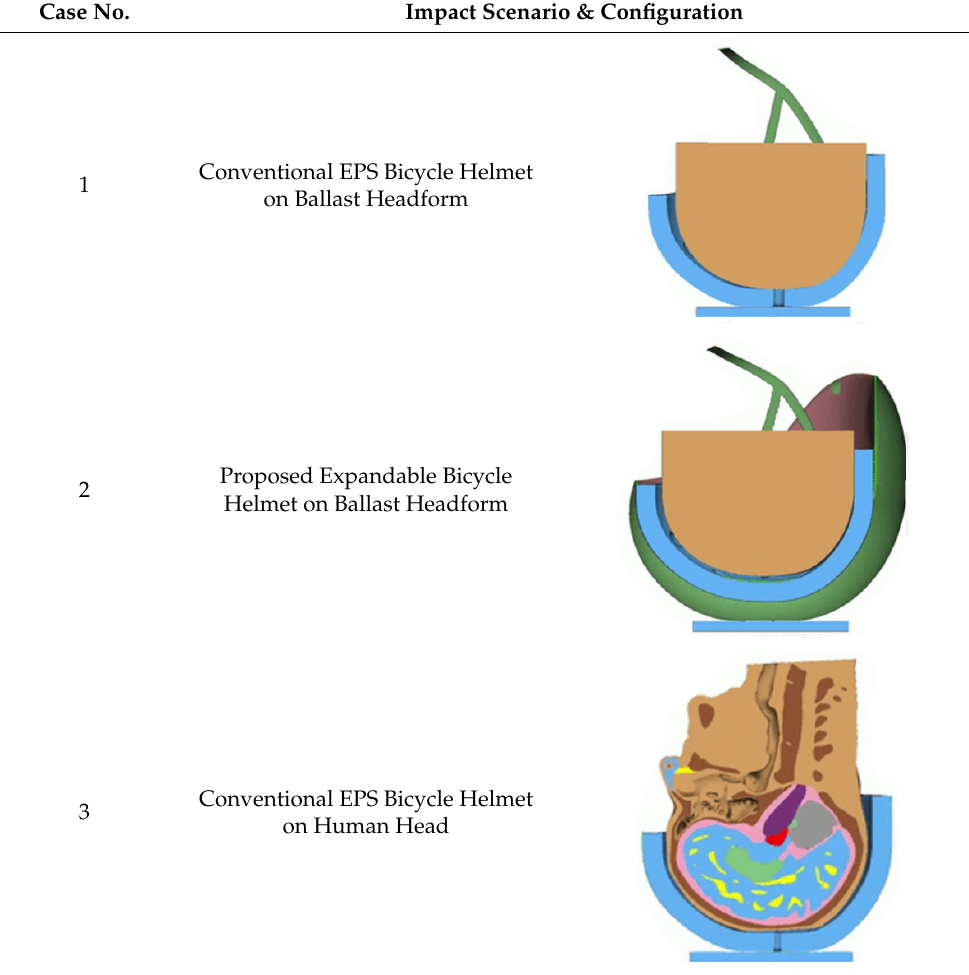
Table 1. Dynamic simulations with various impact scenarios and configurations. Case No.